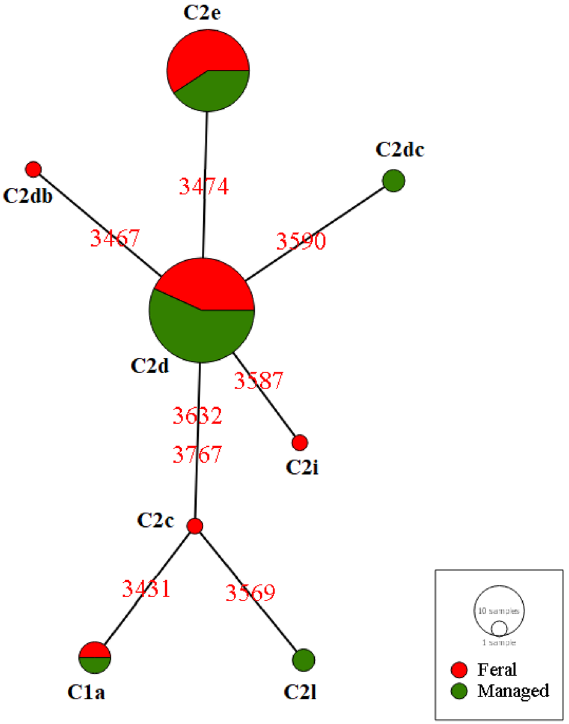
Figure 1. Median-joining phylogeographic network of mtDNA haplotypes detected in two types of honey bee colonies (feral and managed) in the territory of Belgrade based on the variability of the tRNA leu -cox2 intergenic sequence. The size of the node is proportional to the number of individuals. The numbers represent variable nucleotide positions between different haplotypes.